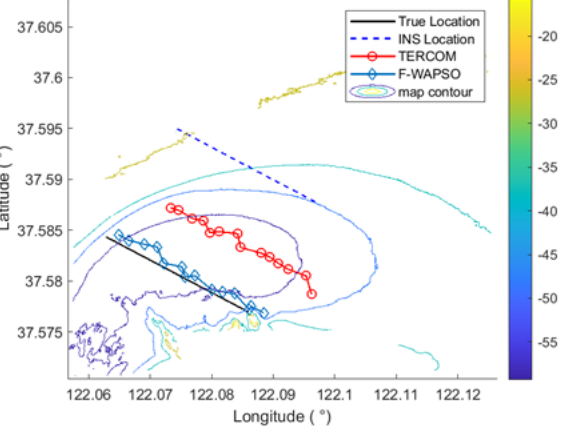
Figure 10. Trajectory D matching results of the two algorithms.